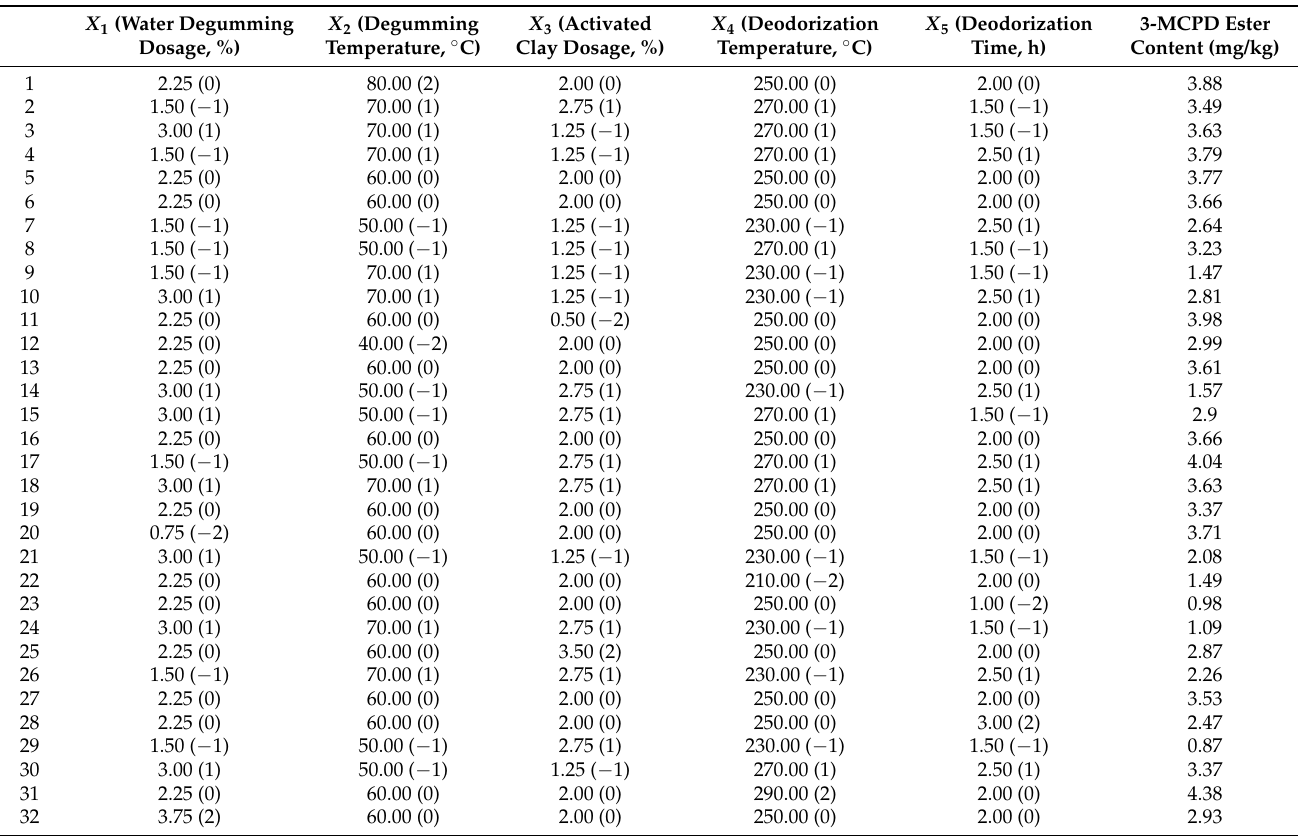
Table 2. Arrangement and results of the response surface